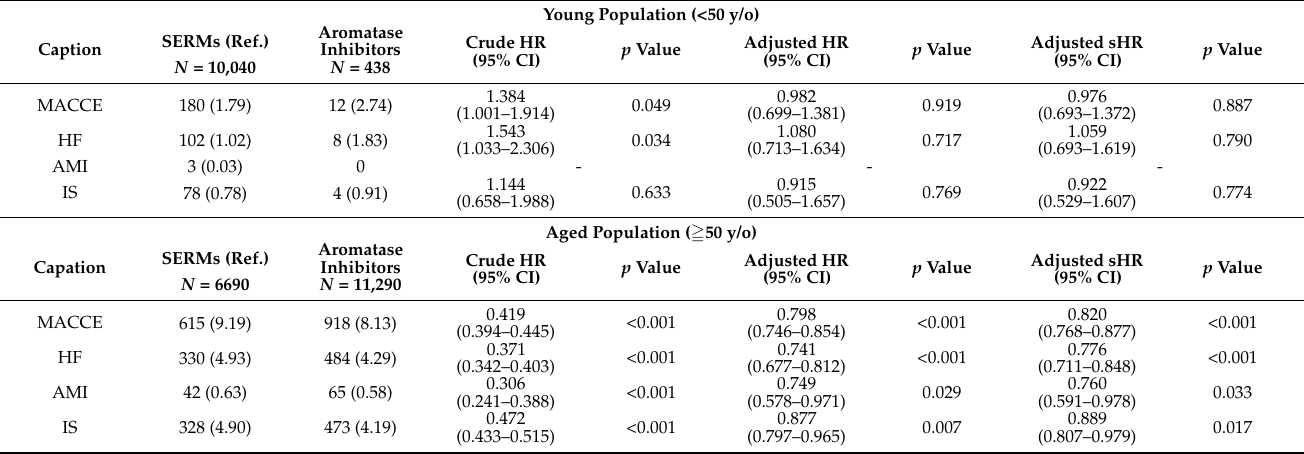
Table 3. The crude and adjusted hazard ratio (HR) of MACCE, AMI, HF and ischemic stroke in users of SERMs and AIs in the young (<50 y/o) and aged ( (cid:61) 50 y/o) population. Young Population (<50